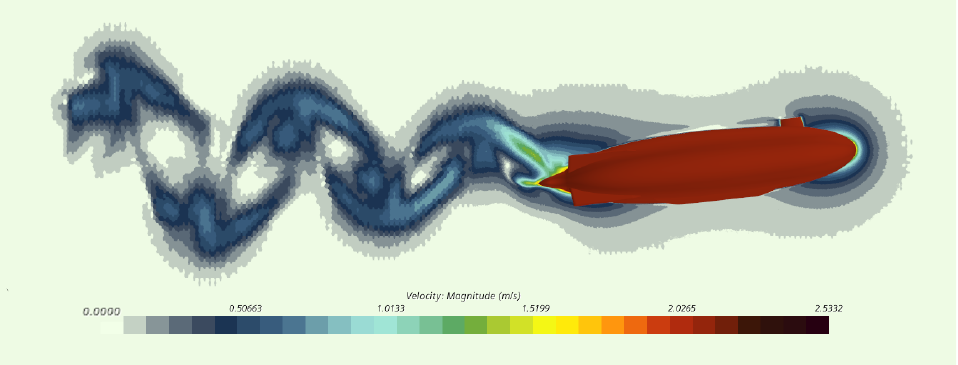
Figure 4. Velocity contour of pure pitch maneuver from